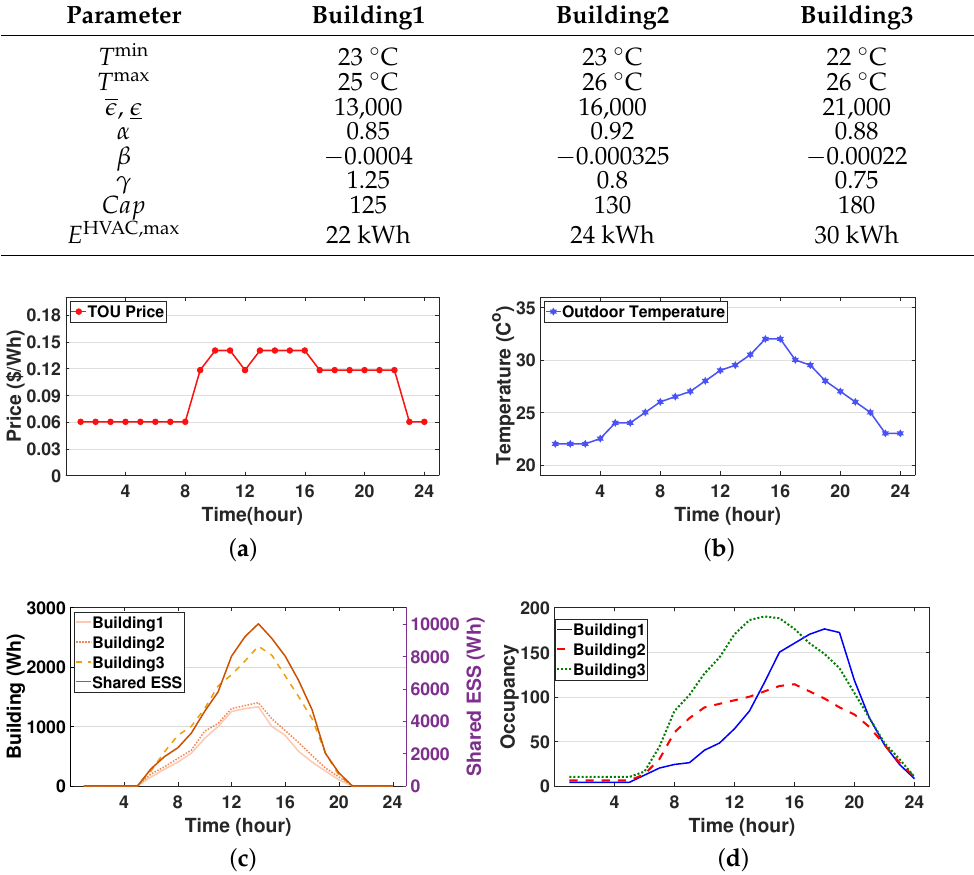
Figure 4. Parameters of electricity price, weather condition, and building occupancy: ( a ) time-of-use (TOU) price; ( b ) predicted outdoor temperature; ( c ) predicted photovoltaic (PV) generation output; and ( d ) daily